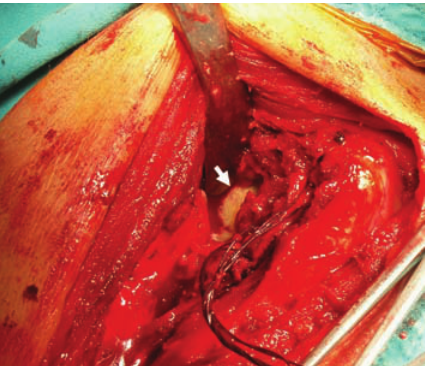
Figure 2: Intraoperative finding of the caseous material in front of the glenoid following the humeral head resection (white arrow).